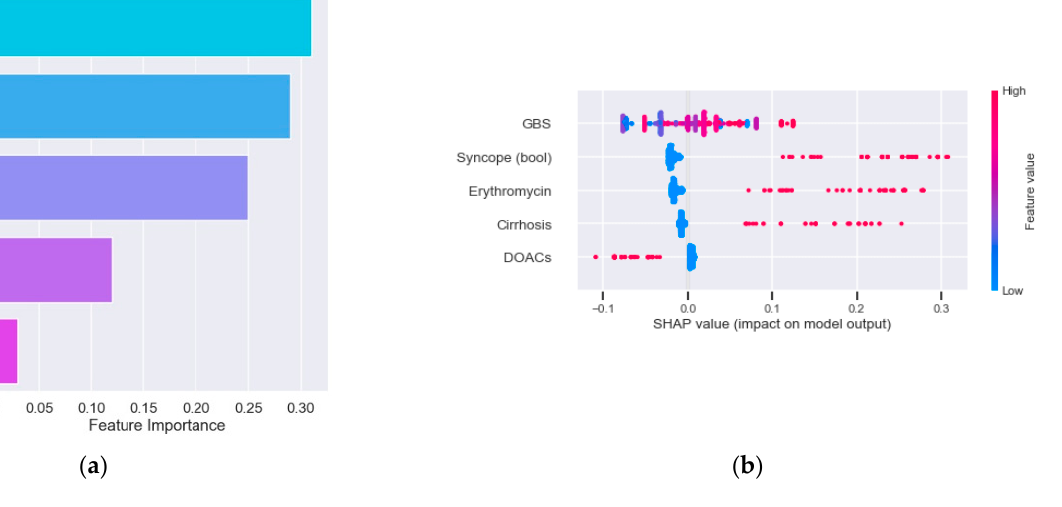
Figure 3. Feature importance in the new modified model for endoscopic intervention. ( a ) SHAP impact plot of the new modified model for endoscopic intervention. ( b ) GBS, Glasgow-Blatchford score; DOACs, direct oral anticoagulants.